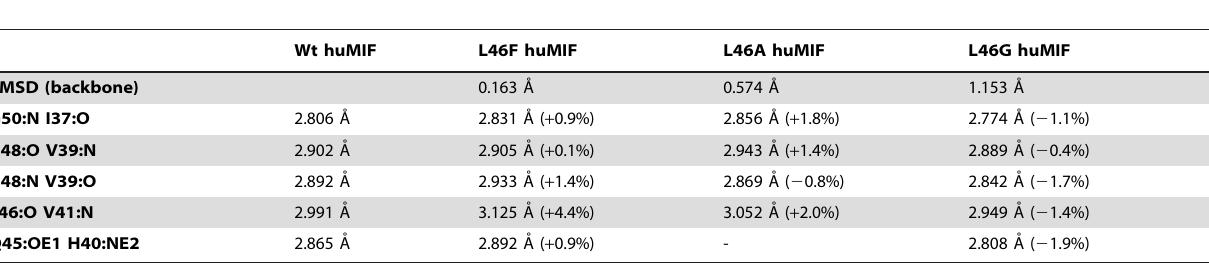
Table 2. Backbone root mean square deviation of Leu46 mutants based on the structure of wt huMIF, and hydrogen bonds distances stabilizing the internal b -sheet involving b -strands b 2 and b 3 (Figure 1); percentages represent the increase/decrease of the hydrogen bond distances in the mutants compared to the wt